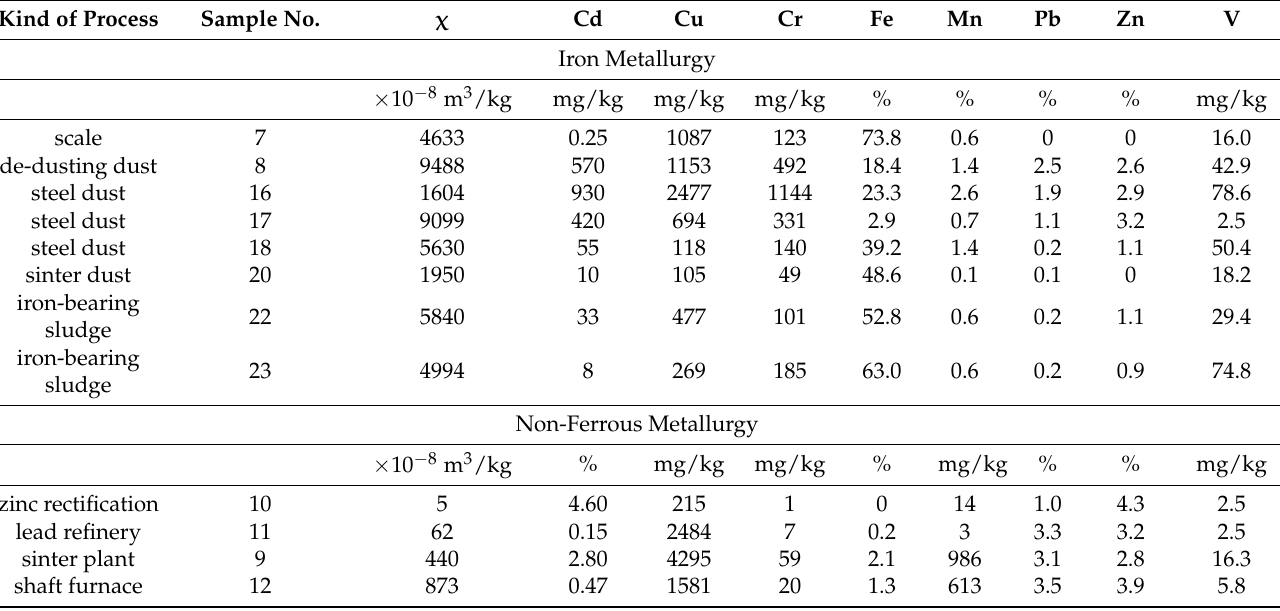
Table 1. Magnetic susceptibility and chemical composition of dust from different iron and non-ferrous metallurgical processes. Kind of Process Sample